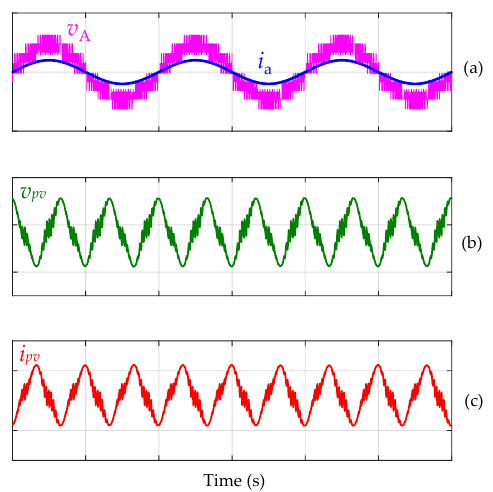
Figure 7. Simulation example of: ( a ) grid current and inverter output voltage, ( b ) PV voltage, and ( c ) PV current, in case of three-phase flying capacitor inverter.